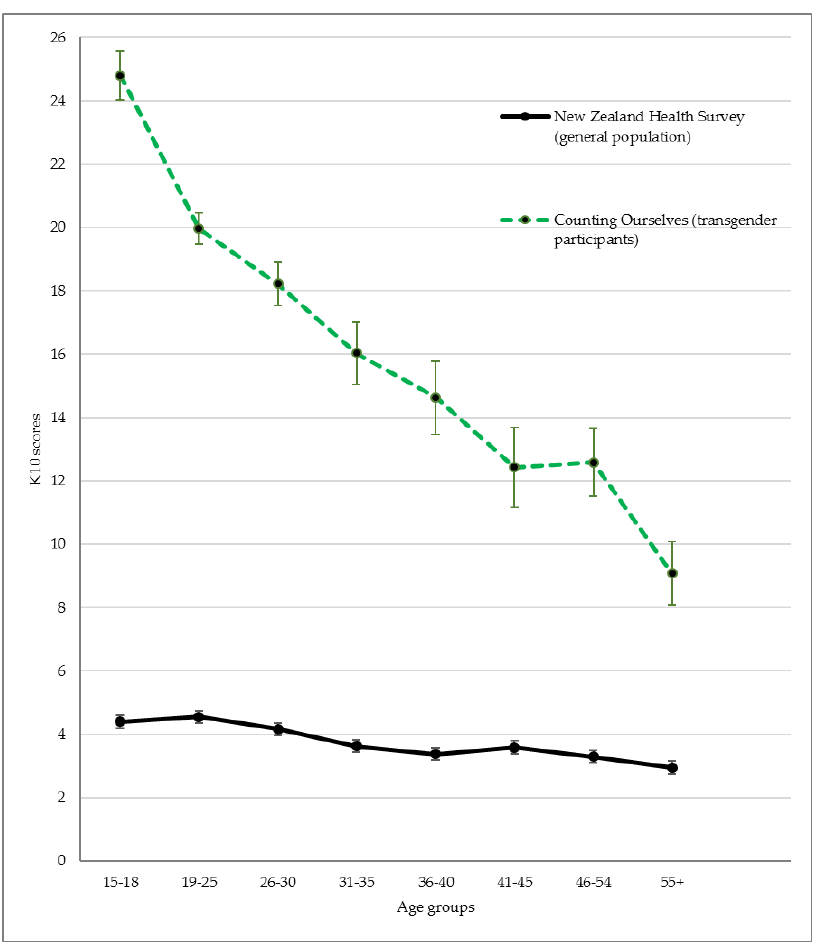
Figure 2. The inequities in K10 psychological distress scores between Counting Ourselves participants and the Aotearoa/New Zealand general population across age